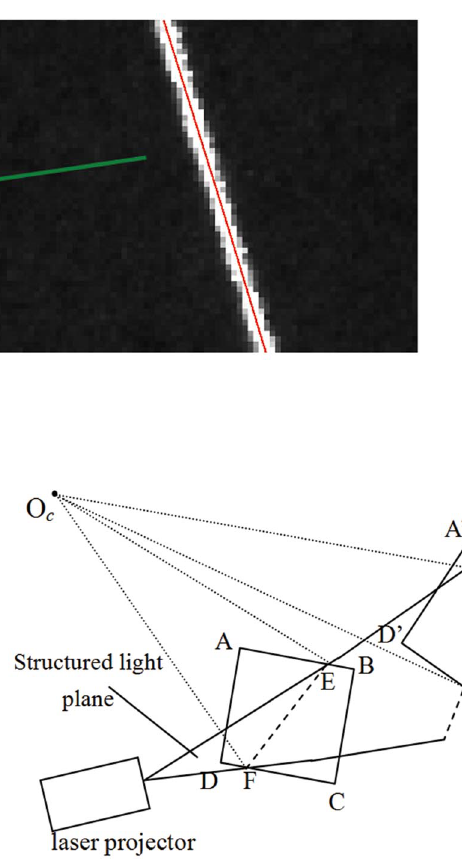
Figure 10. Fitting the structured light plane.